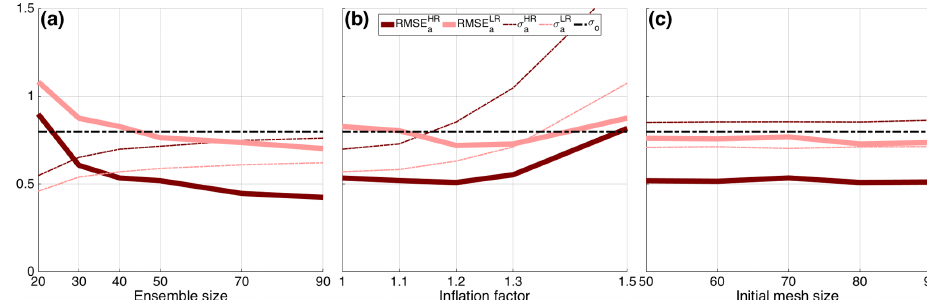
Figure 11. Same as Fig. 8, but using KSM.